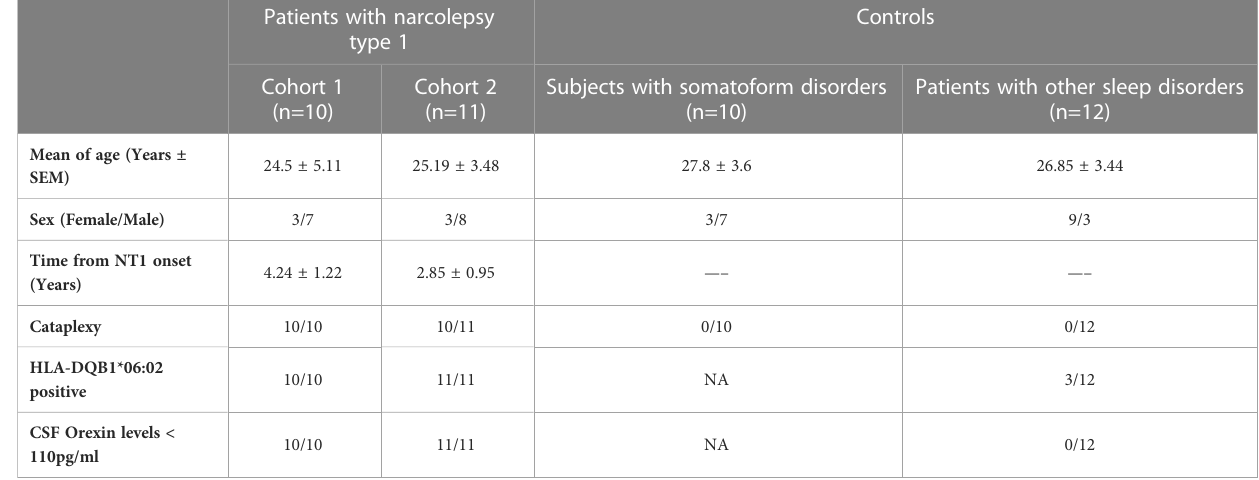
TABLE 1 Clinical and paraclinical characteristics of NT1 patients and controls included in the